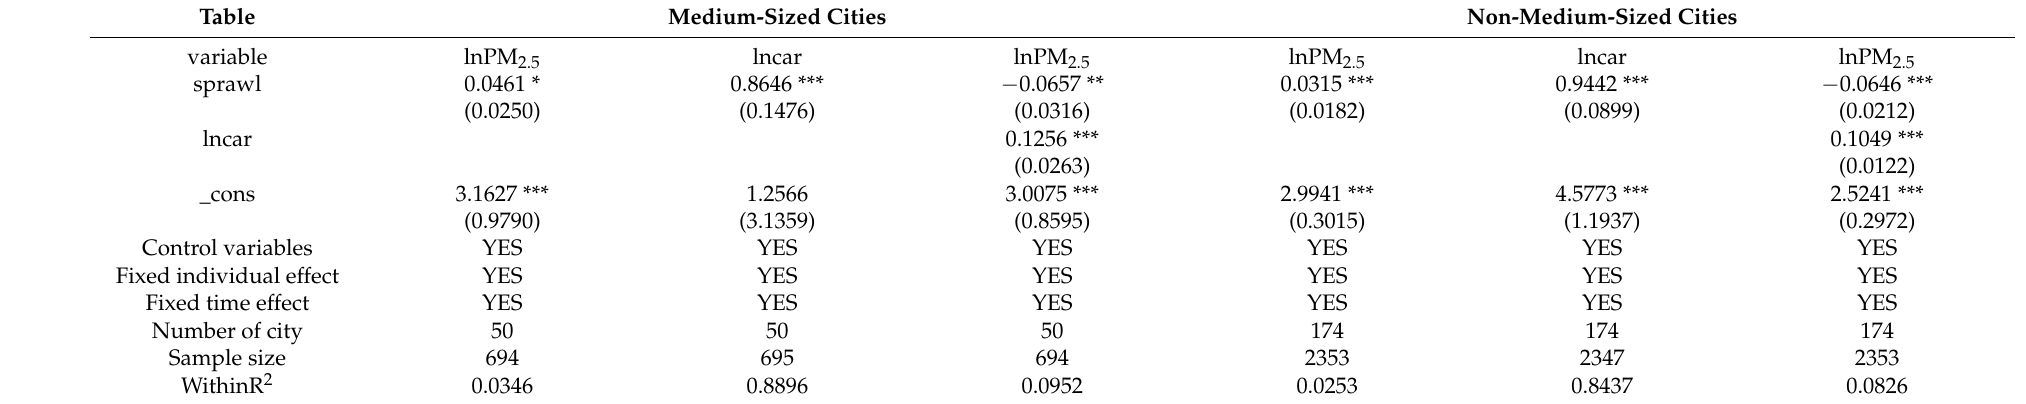
Table 4. Regression results of city size by sample.